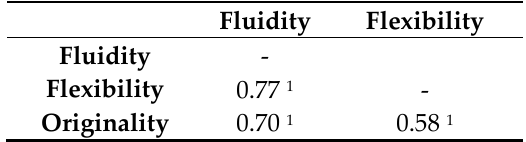
Table 2. Correlation among the scores of the Toy Improvement Task (N =